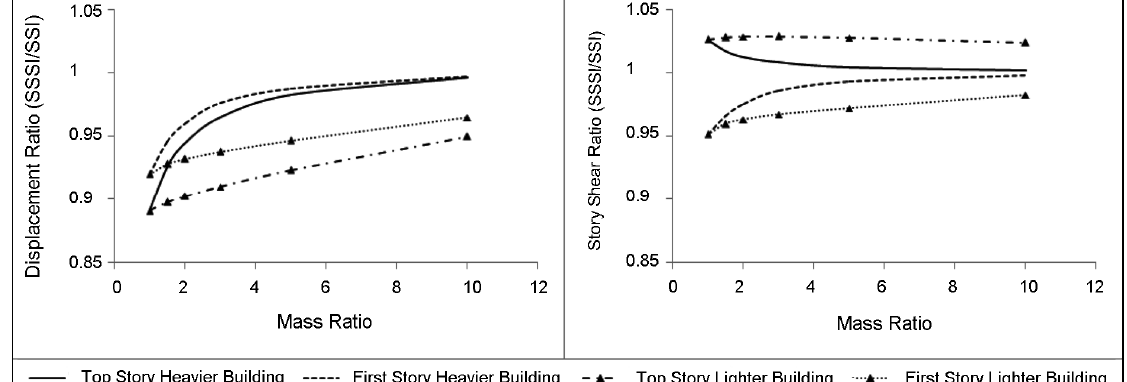
Fig. 6. Effect of mass ratio on building responses Fig. 8 indicates earthquake induced relative